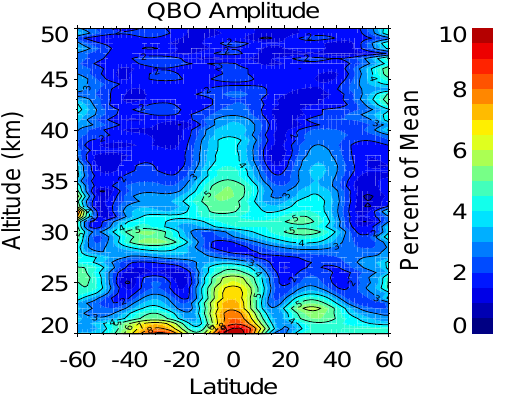
Figure 6. Amplitude of oscillation of the QBO term as a percentage of the local mean.